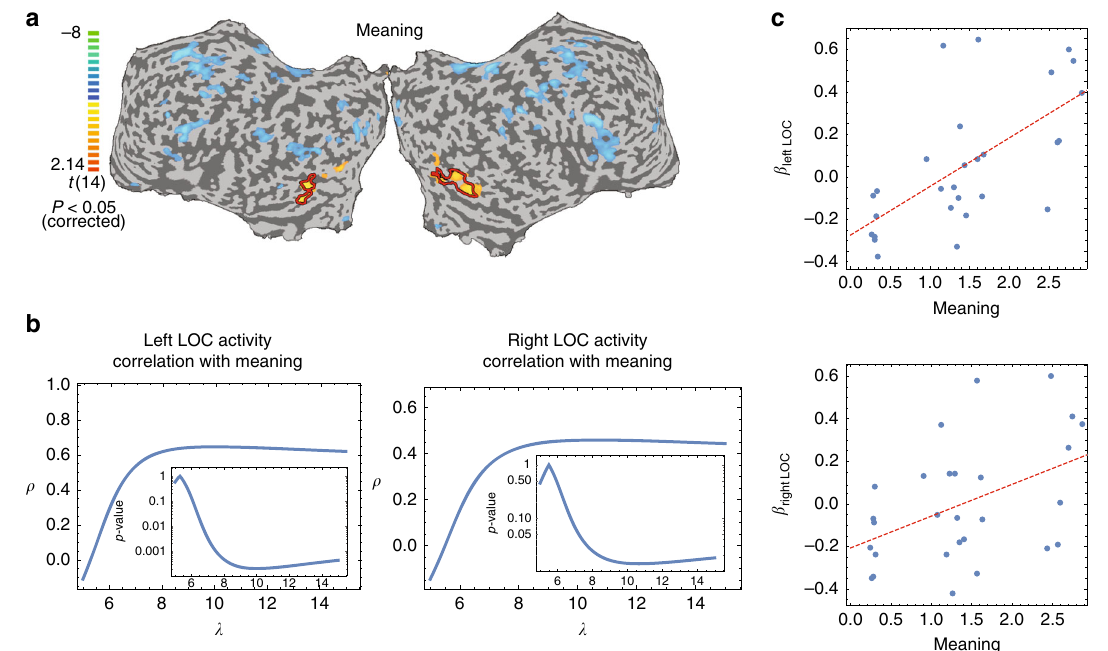
Fig. 3 Brain activity correlates with a fold decay of the meaning across shapes ’ network. a Parametric mapping. Cortical activity maps of multi-subject, random effect, parametric GLM analysis of meaning presented on an unfolded cortex ( N = 15), map is corrected for multiple comparisons, p < 0.05. Color scale indicates t- values. Yellow-orange scale represents regions, which showed positive parametric relation with meaning scores (A non-parametric, t -max correction analysis to control for FWER showed a t -value of 1.7 for α = 0.05, see Methods). Blue-green scale represents regions which showed negative parametric relation with meaning scores. b Analysis of brain activity correlation strength (Inset, p -value) as a function of the decay factor from a core shape ( x- axis – decay factor λ , where meaning decays by λ - d where d is the distance on the network of shapes). Maximal correlation and p -value are attained at a fold decay of about λ = 10 (see Supplementary Information for linear and power-law decay functions analysis). c Correlations of LOC activity and meaning. Scatter plots present the relation between the averaged meaning of blocks ( x- axis) and the averaged brain activity ( N = 15, normalized beta weight, y- axis) in bilateral LOC. Each dot represents one block. Spearman correlation; left LOC, r = 0.65, p < 0.0002. right LOC, r = 0.48, p <